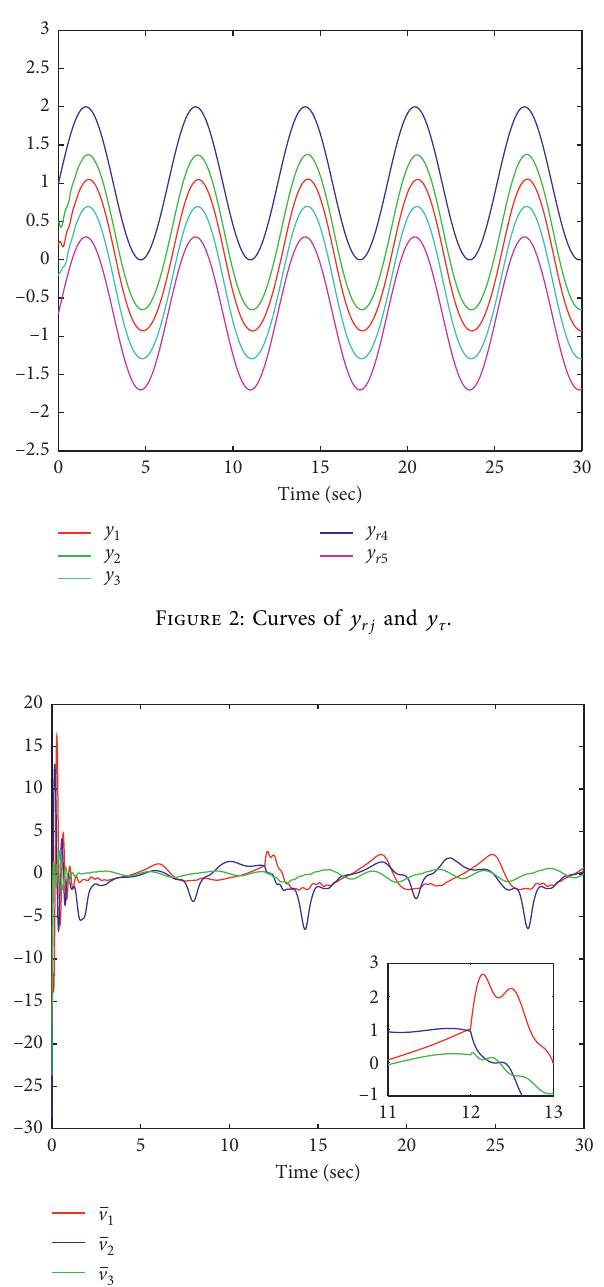
Figure 3: Curves of u